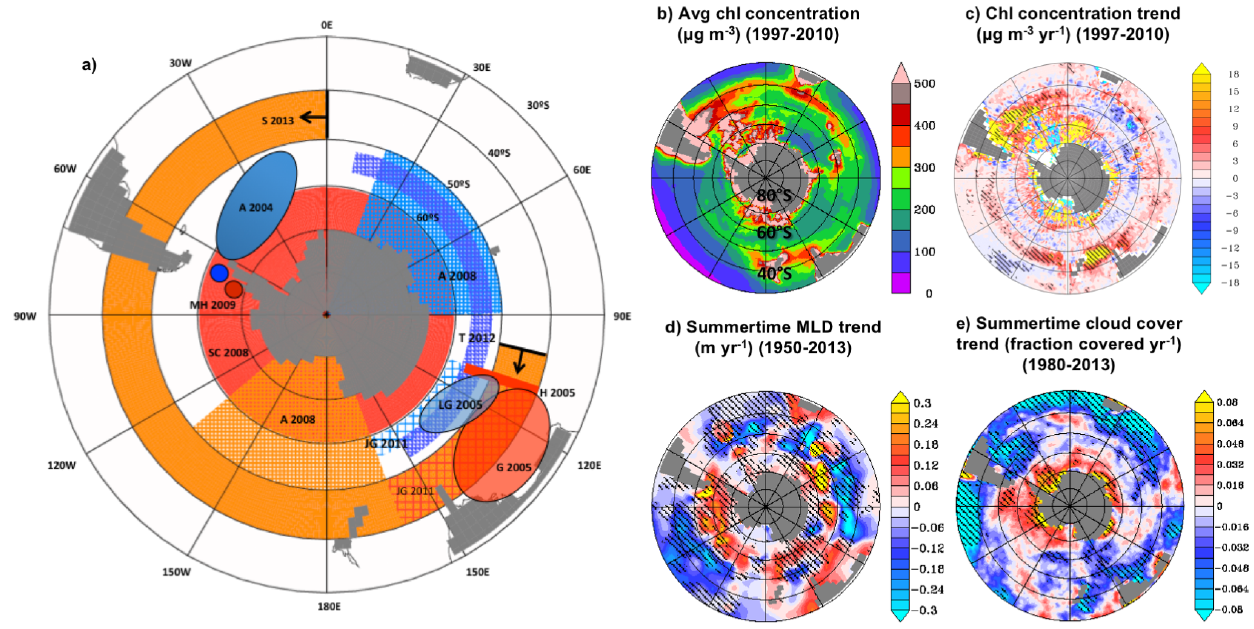
Figure 7. Observed phytoplankton trends and variability. (a) Summary of past studies looking at trends and SAM-driven variability in phytoplankton biomass and productivity. Orange/red regions are areas where past studies have found positive trends in phytoplankton biomass or productivity, whereas blue regions are areas where past studies have found negative trends. Each coloured region or point is labelled with the corresponding publication. See Table S4 for further details on each study. (b) Average monthly SeaWiFS chl concentrations, along with yearly trends in (c) chl, (d) summertime cloud cover from ERA-INTERIM reanalysis, and (e) summertime MLD from Hadley reanalysis. Hatching denotes regions where trends calculated as least-squares best-fit lines to the time series are significant using a two-tailed t test at p < 0 .